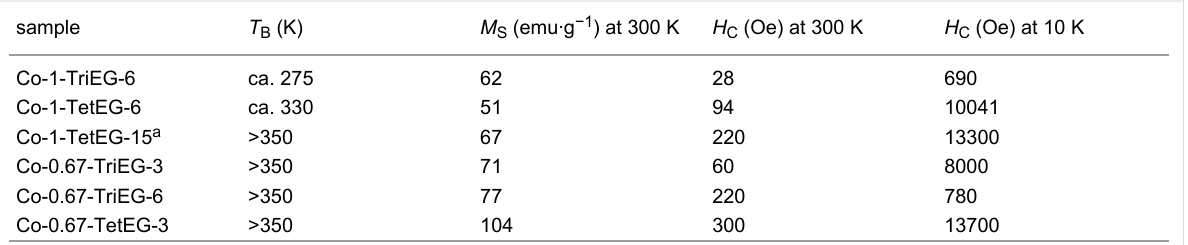
Table 2: Blocking temperature ( T B ), saturation magnetization ( M S ) and coercive field ( H C ) of the Co x Fe 3 − x O 4 nanoparticles.